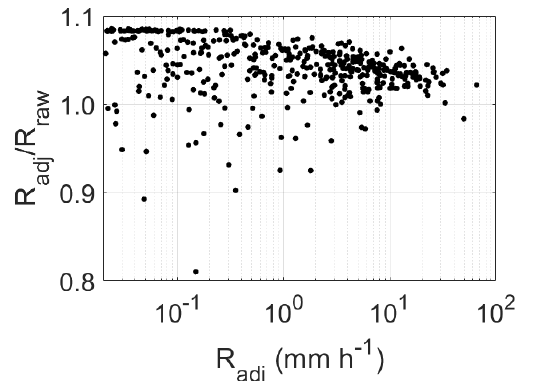
Figure 10. A different way to visualize the results seen in Figure 8. The ratio between the corrected rain rate ( R adj ) and the rain rate estimated from the uncorrected data record ( R raw ) plotted against the corrected rain rate R adj